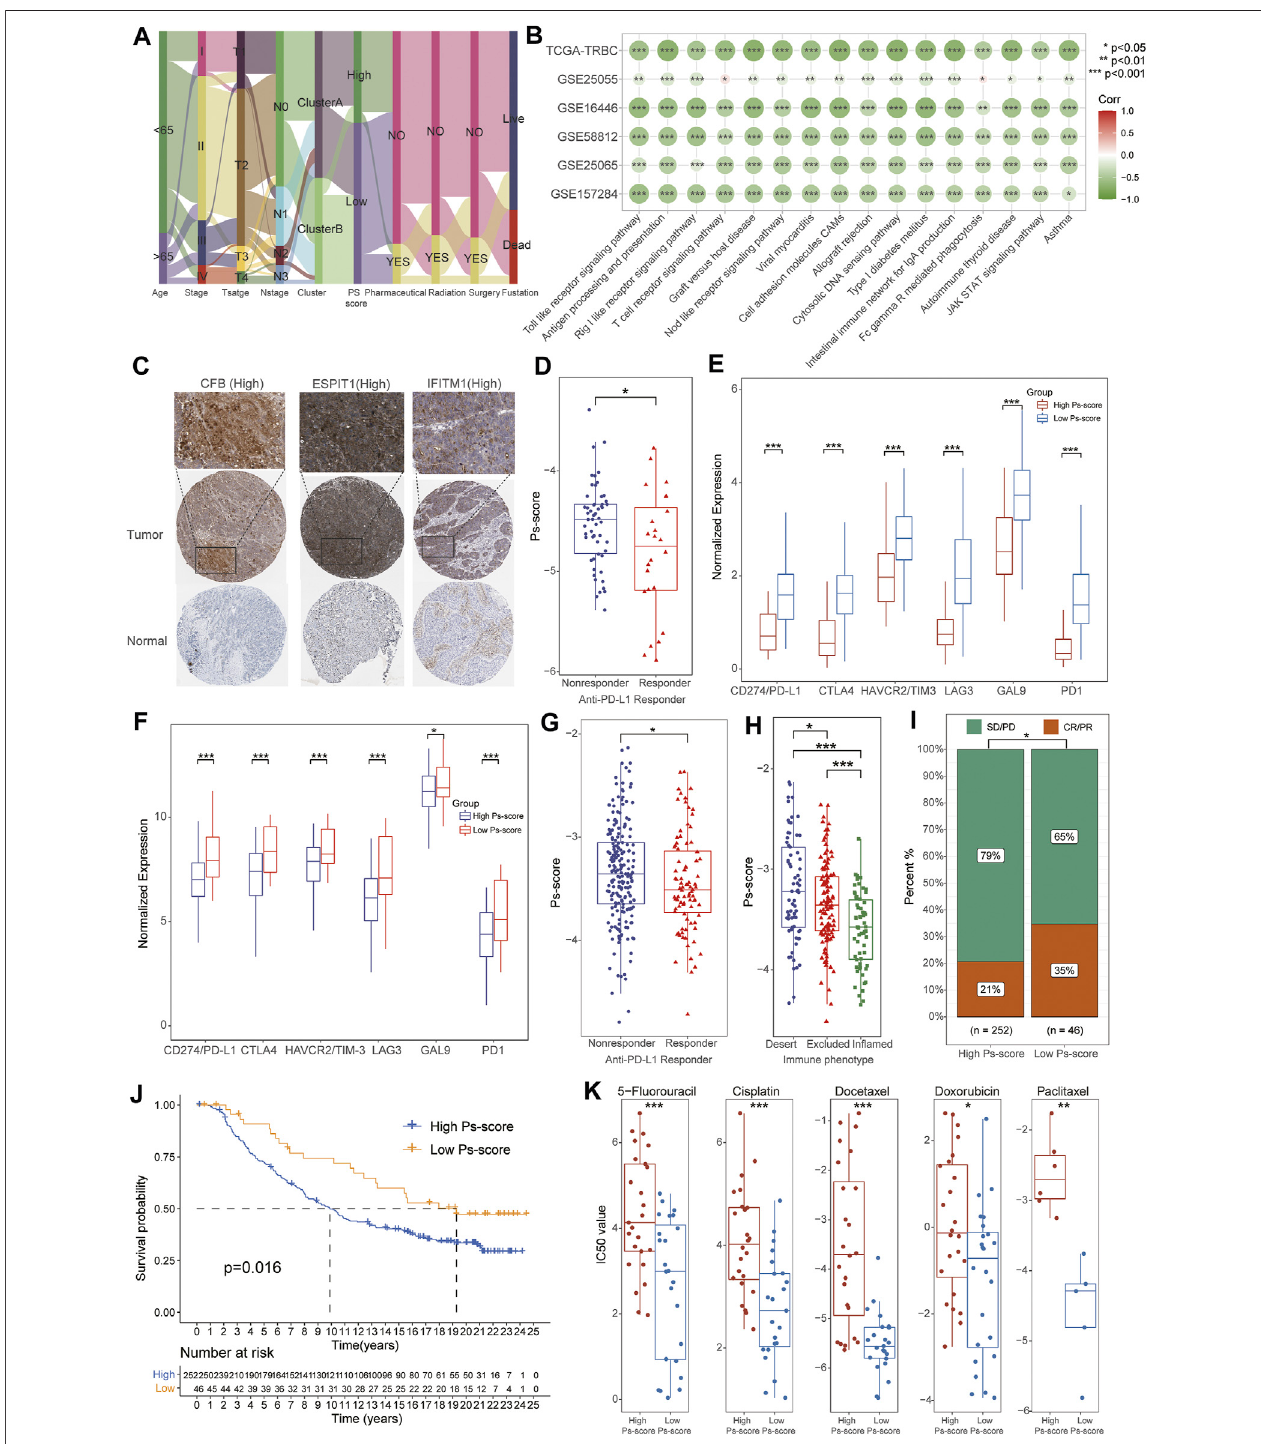
FIGURE 6 | The signi fi cance of Ps-scores in the prediction of response to immunotherapy and common chemotherapeutics for TNBC. (A) Alluvial diagram visualizing the status changes from different characteristics of patients. (B) Correlation analysis of Ps-scores and GSVA pathways in TCGAand GEO data sets. The size ofnodes representsthecorrelation coef fi cient,andtheredorgreenrepresentspositiveornegativecorrelation,respectively. (C) TheimmunohistochemicalresultsofPs- score-related genes from the HPA database. (D) The box plots displayed patients with better responses to PD-L1 treatment exhibited higher Ps-scores using GSE157284. (E) Therelativeexpressionofimmune-checkpointgeneswassigni fi cantlyincreasedinthehighPs-scoresgroupsofGSE157284datasets. (F) Therelative expressionofimmune-checkpointgeneswassigni fi cantlyincreasedinthehighPs-scoresgroupsofIMvigor210cohorts. (G) Theboxplotsindicatedpatientswithbetter